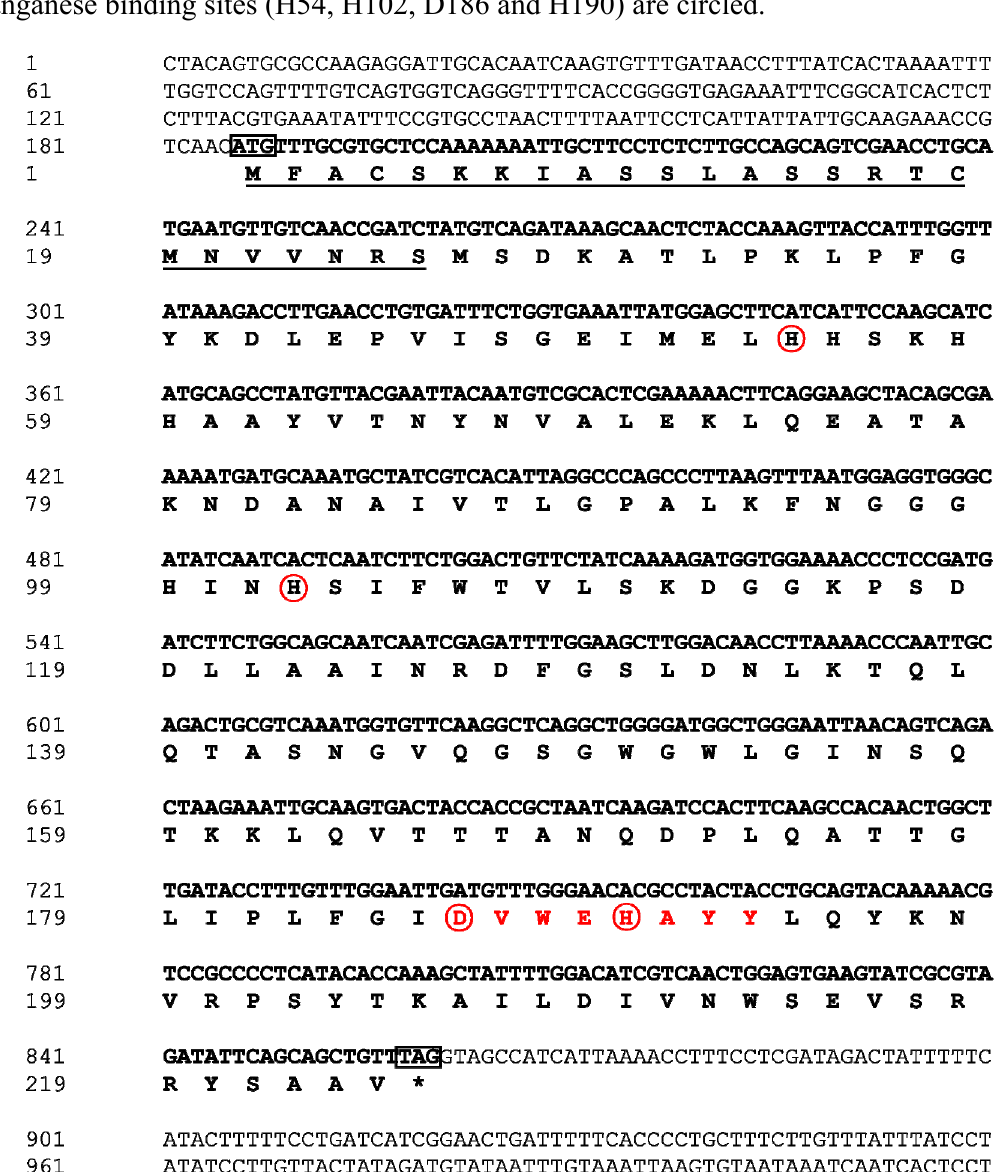
Figure 1. Nucleotide and deduced amino acid sequences of mitochondrial